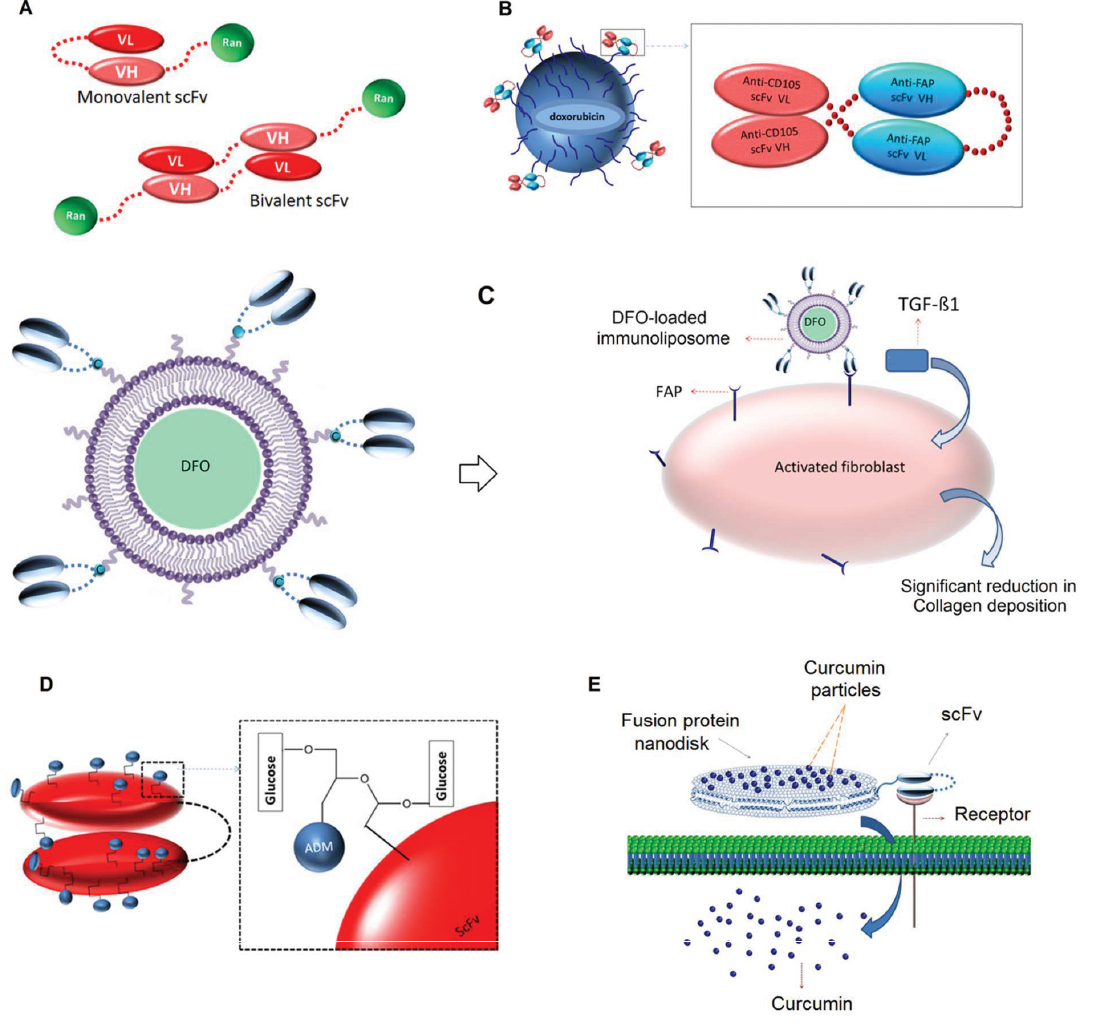
Figure 3. Structure and/or functional mechanism of some scFv-based drug carriers. (A) Monovalent and bivalent formats of Ranpirnase– scFv fusion peptide. Ranpirnase and scFv are joined together with a linker peptide. (B) Schematic view of a doxorubicin-loaded bi- specific IL. The targeting ligand is a fusion peptide composed two scFv molecules, anti-FAP scFv and anti-CD105 scFv. (C)